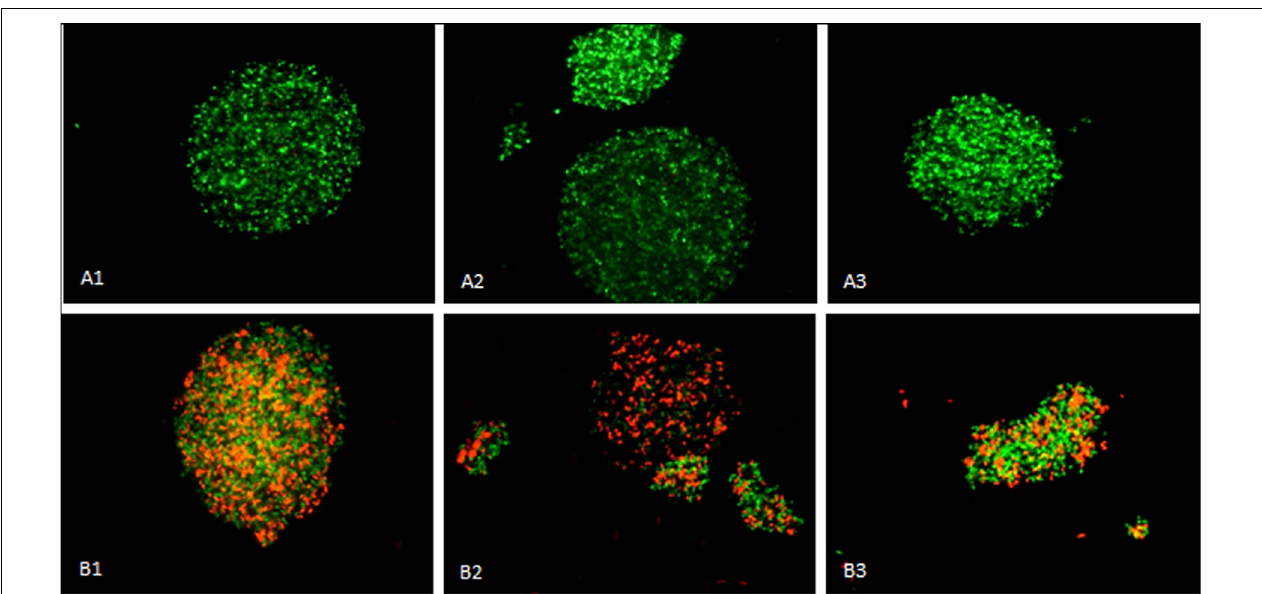
FIGURE 3 | Mycobacterium vaccae cells grown in the presence of ethanol (A1–A3) and MTBE (B1–B3) presented extensive aggregation with the formation of clusters. Images 1–3 are from independent samples taken at 45 h of cultivation. Viable cells are stained green by Syto R (cid:13) 9 whilst non-viable cells are stained red by propidium iodide. Horizontal field width: 800 µ m; vertical field width: 600 µ m.